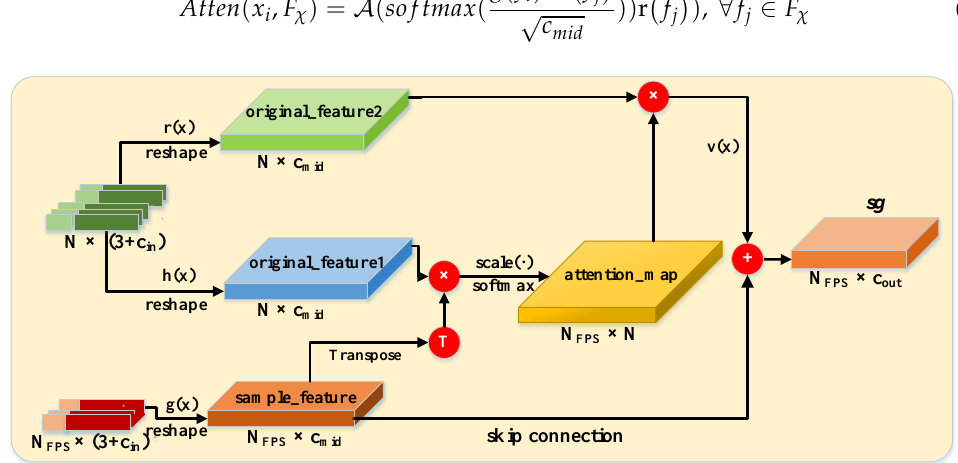
Figure 5. Global features are aggregated based on self-attention.